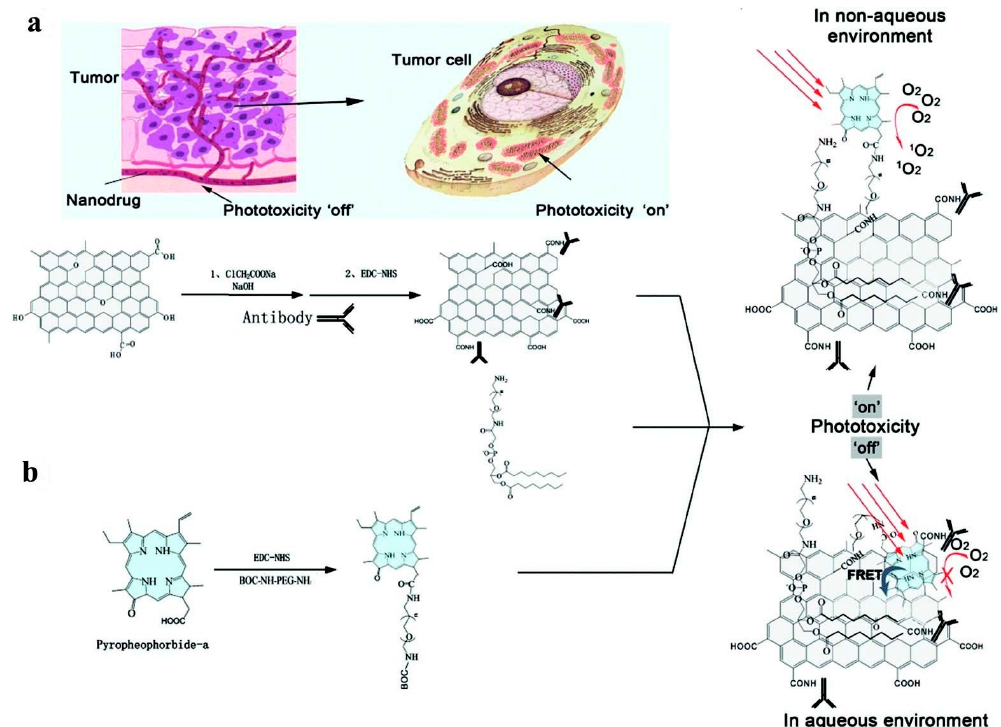
Figure 10. Synthesis and mode of action of PPa-NGO-mAb. ( a ) Application of PPa-NGO-mAb with phototoxicity switching and tumor cell mitochondria targeting; ( b ) Synthesis of PPa-NGO-mAb and its two states in different environments. Image adapted with permission from [179].